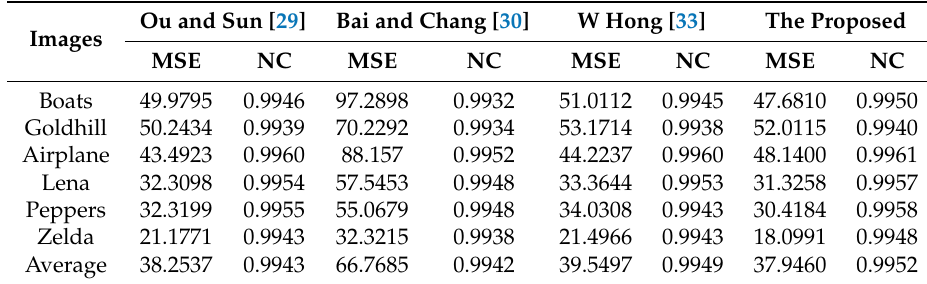
Table 3. Performance comparison of the MSE and Normalized Cross-Correlation (NCC) between the proposed and previous schemes (using 150,000